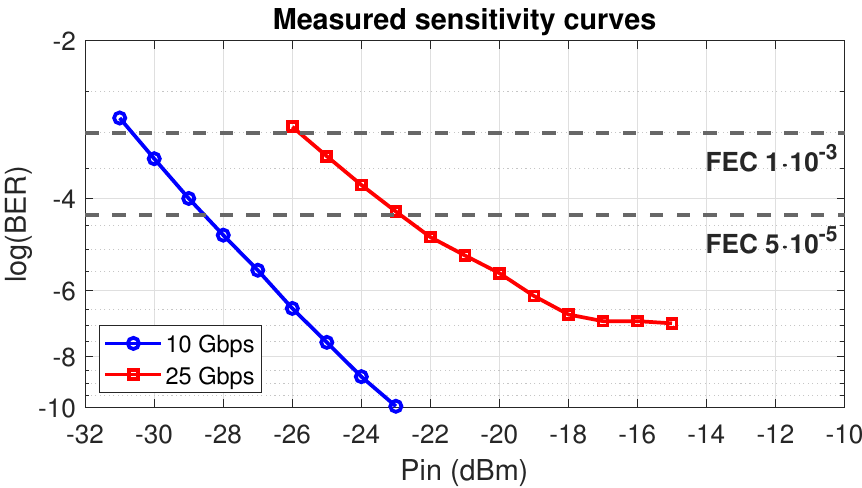
Figure 13. Measured BER as a function or received optical power ( P in ) at 10 and 25 Gbps data rates. Line markers indicate the NG-PON2 and Ethernet FEC limits at BER = 1 × 10 − 3 and BER = 5 × 10 − 5 ,